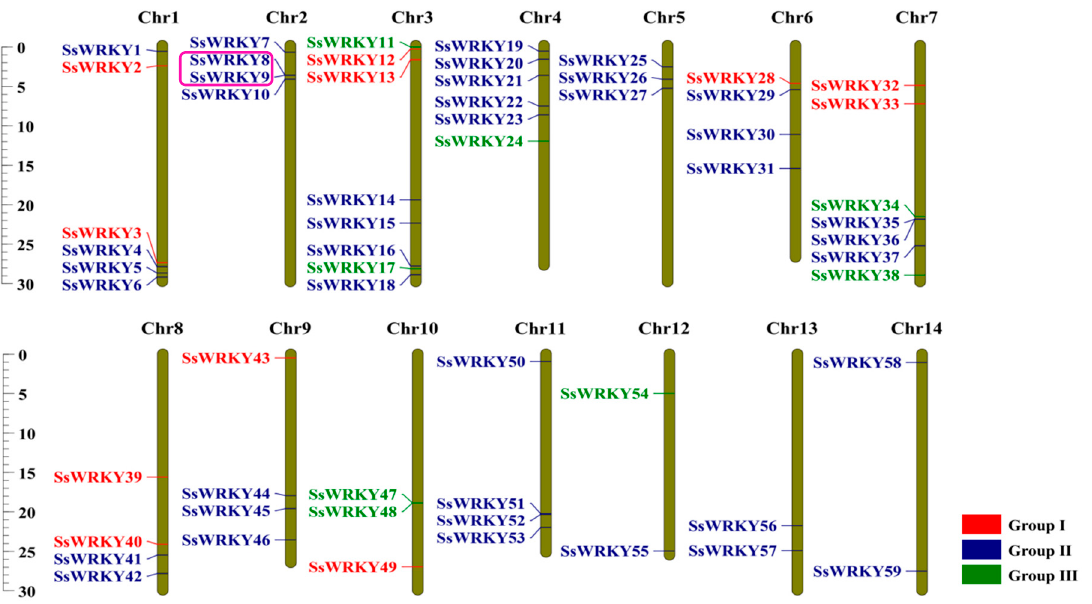
Figure 4. SsWRKY gene distribution across 14 chromosomes of S. siamensis . Tandem duplicated genes are marked with a pink box. Vertical bars represent chromosomes. The different groups of SsWRKY genes are colored red, blue, or green. Base-pair positions are indicated on the left.